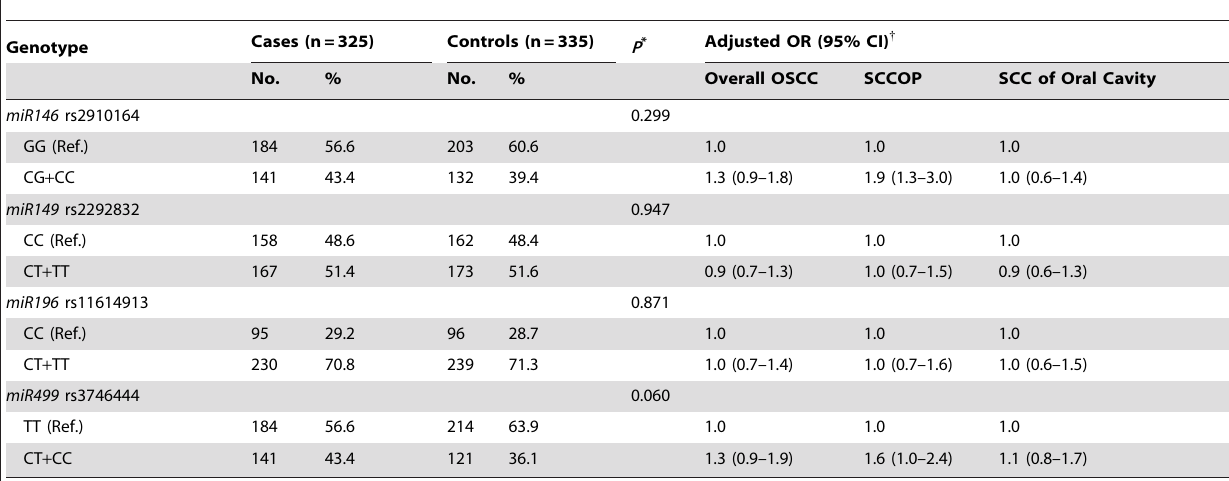
Table 3. Association of MicroRNA SNPs with OSCC